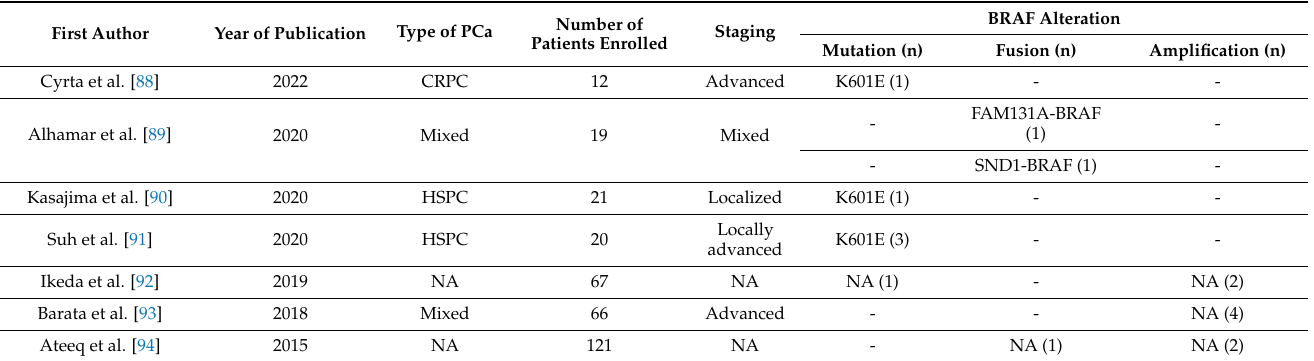
Table 3. List of studies on PCa genomic profiling that reported molecular alterations in the BRAF